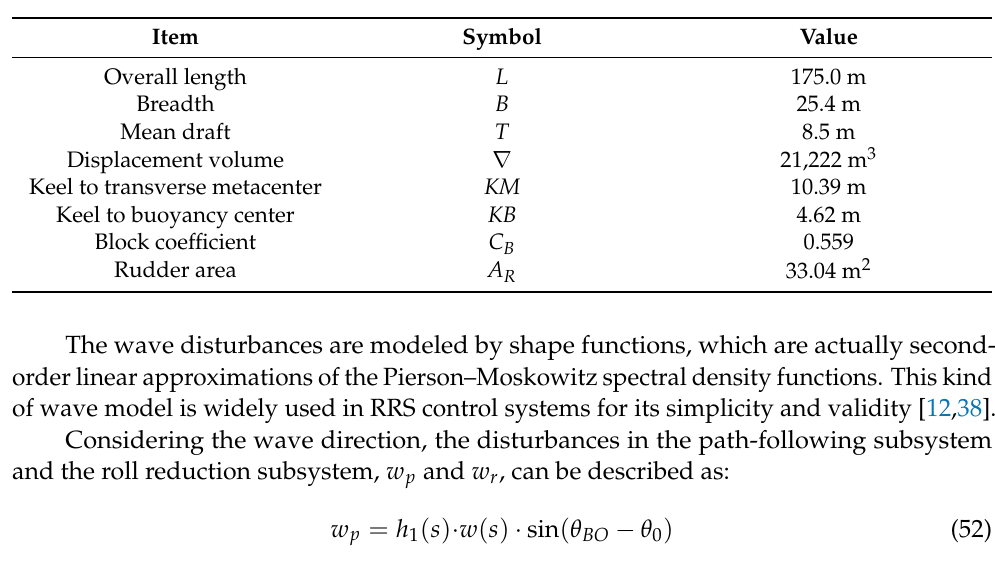
Table 1. Principal particulars of the container